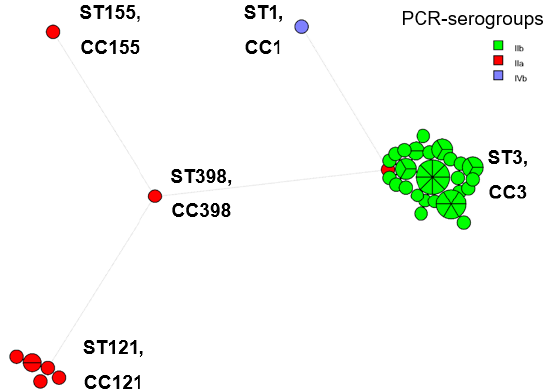
Figure 5. Minimum spanning tree (MST) based on cg/wgMLST (Core Pasteur Scheme) of L. mono- cytogenes isolates. This MST offers better resolution between similar strains compared to the MST presented in Figure 4.